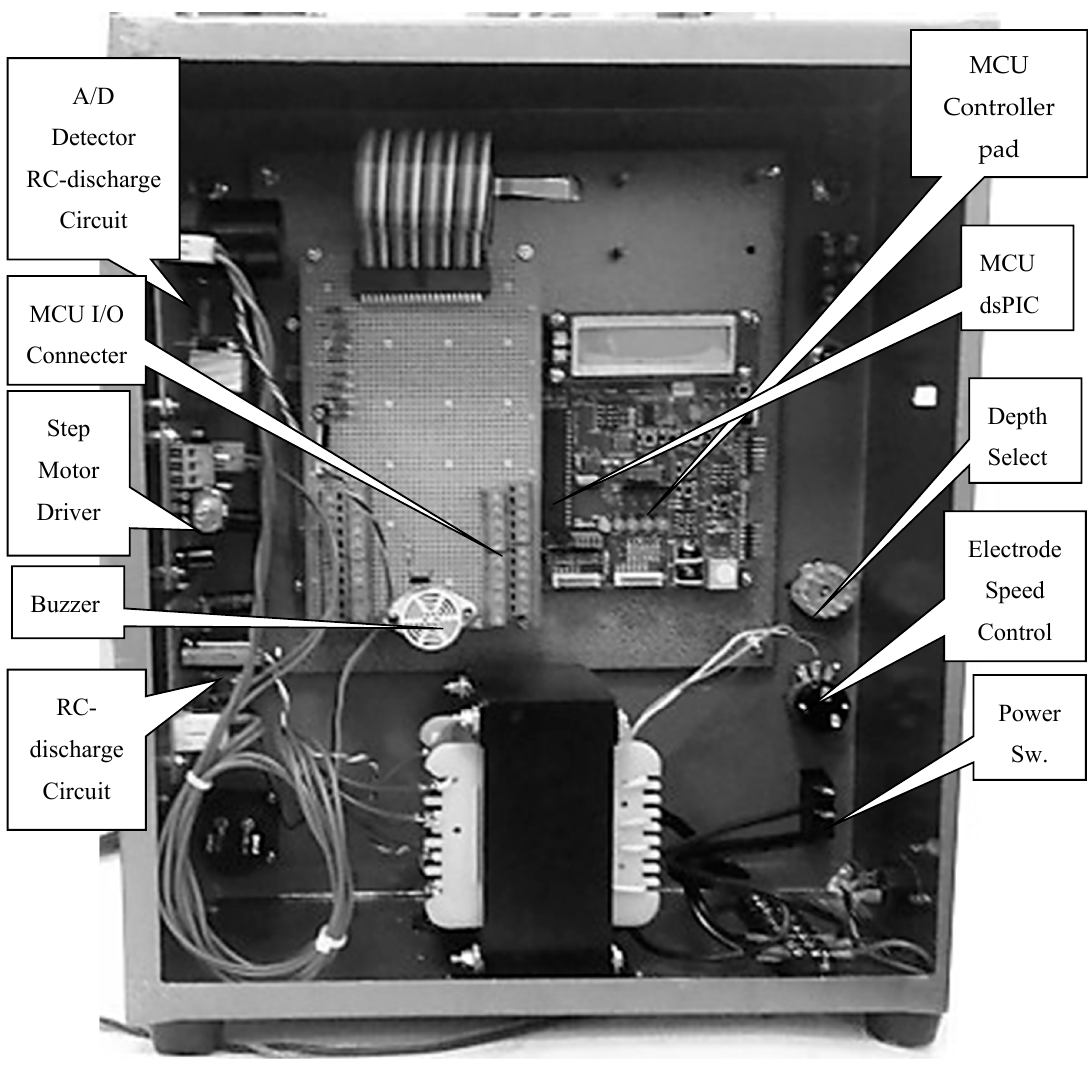
Figure 8. Internal structure of the desktop micro-EDM system.